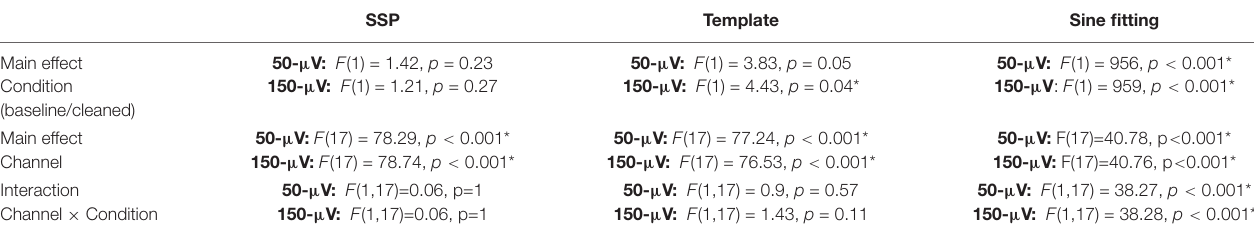
TABLE 3 | Results of the two-way ANOVA on the IAF amplitude changes. SSP Template Sine fitting